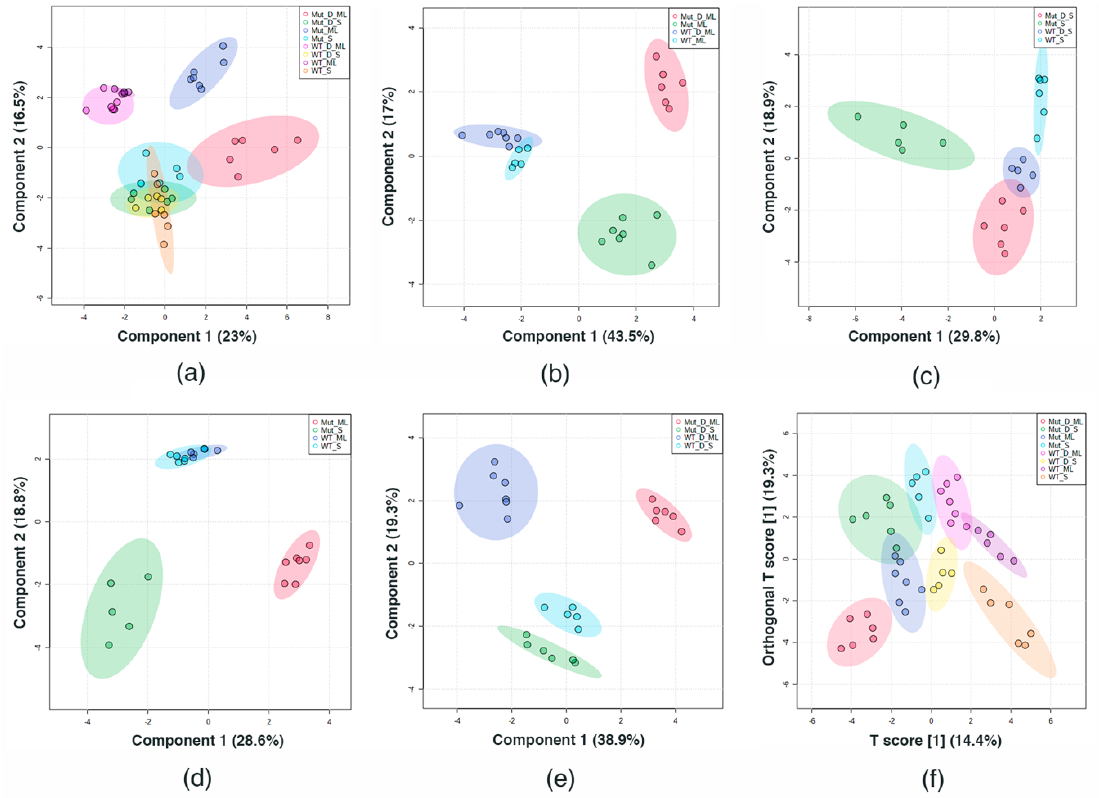
Figure 3. 2D sPLS–DA ( a ) Contains all sample types: showing overlap of WT ML with WT D ML and the overlap of all stationary phases. Mut ML is separate, and Mut D ML is separate. ( b ) Contains only mid log samples, showing slight overlap of WT ML with WT D ML and complete separation of Mut ML and Mut D ML. ( c ) Contains only stationary phase samples, showing slight overlap of WT D S and Mut D S, and complete separation of WT S and Mut S. ( d ) Contains unchallenged samples, showing a complete separation of Mut ML and Mut S samples and a 2D overlap of the WT ML with WT S (overlap not present in the 3D plot (Figure S7d)). ( e ) Contains only DABCOMD challenged samples, showing complete separation of all sample types. ( f ) 2D ortho PLS–DA c ontaining all sample types: demonstrates the greatest degree of separation with all sample types together, with only an overlap of the oval of WT ML with the oval of WT D ML, and an overlap of the oval of Mut D S with the ovals of WT S and Mut ML.